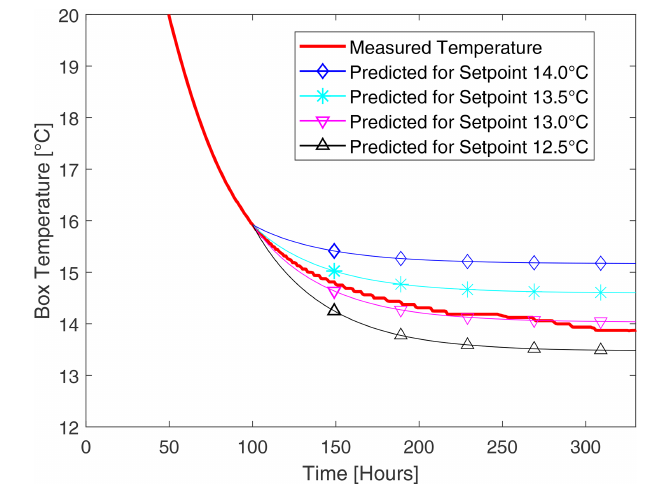
Figure 9. Set-point scenarios and effect on predicted box tempera- ture. Comparison with the actual measured temperature/set point of 13 ◦ C.